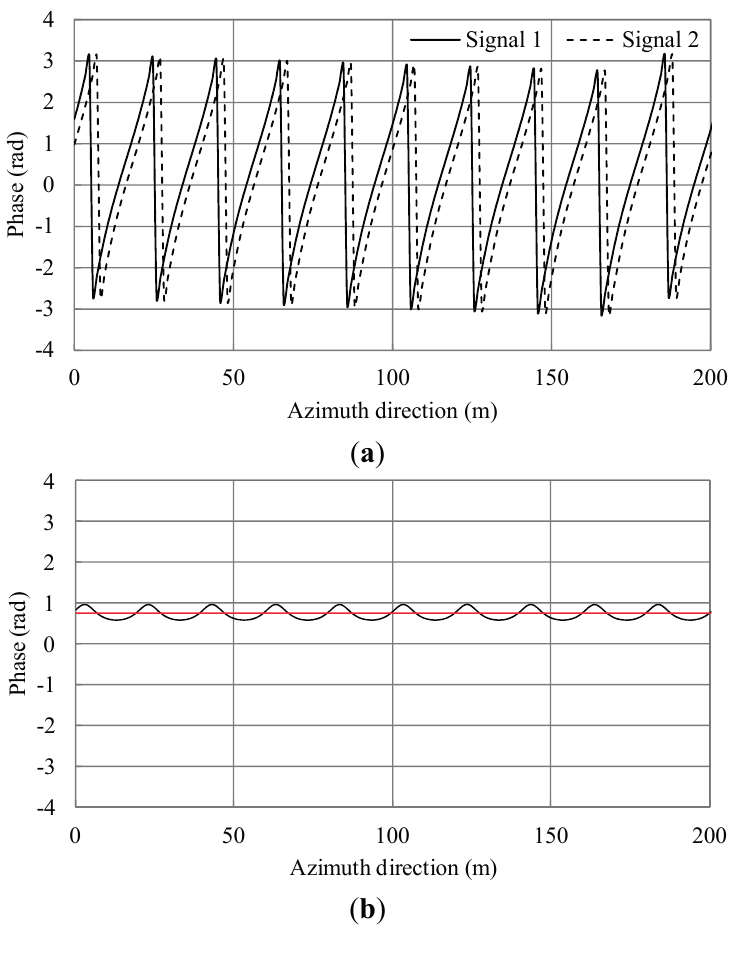
Figure 5. Simulation results of a single Bragg resonant wave. ( a ) Phases of simulated SAR signals of master and slave antennas in the azimuth direction; ( b ) Phase difference of (a). The black line shows the phase differences. The red line shows the